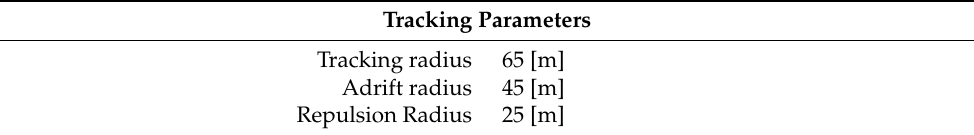
Table 5: Tracking parameters Table 5. Tracking